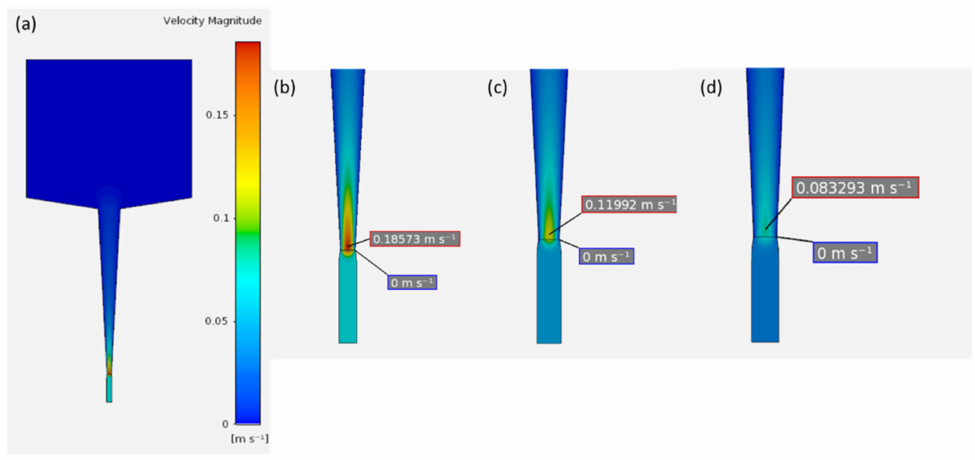
Figure 11. Velocity distribution of rice paste with different nozzle sizes: ( a ) fluid domain, ( b ) nozzle size 0.8 mm, ( c ) nozzle size 1.0 mm, and ( d ) nozzle size 1.2